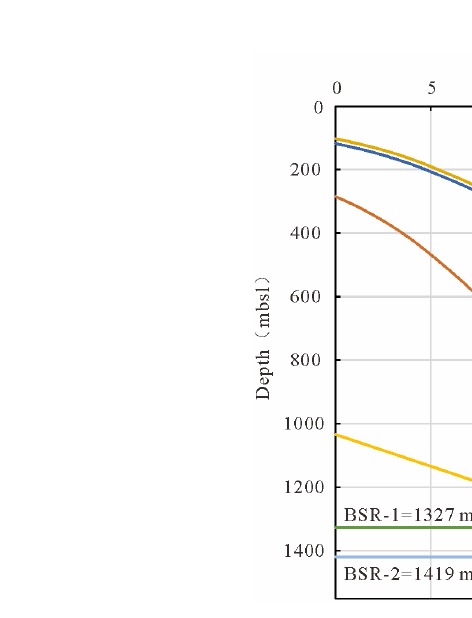
FIGURE 11 Calculation of the GHSZ with different hydrate gas compositions at point A at Site